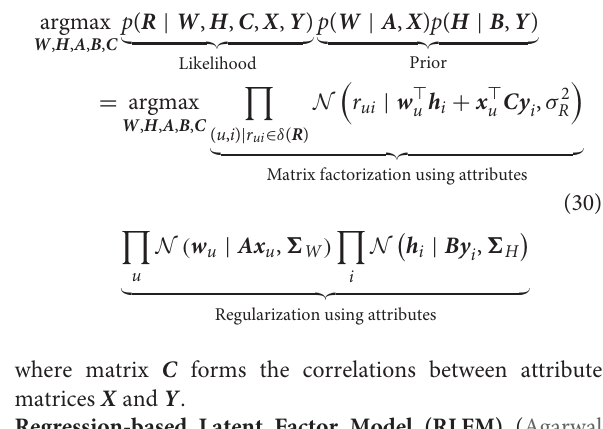
where θ = { c , d , A , B , α , β , γ } and δ ( R ) is the set of non- missing ratings for training. Biased matrix factorization